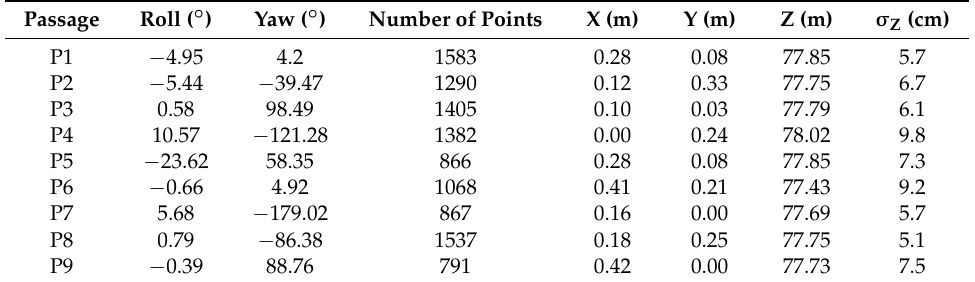
Table 4. Results of the uncertainty assessment of LiDAR height measurements in in-flight conditions. X and Y are the offset (in m) between the lower left angle of the target and the origin indicated in Figure 6.